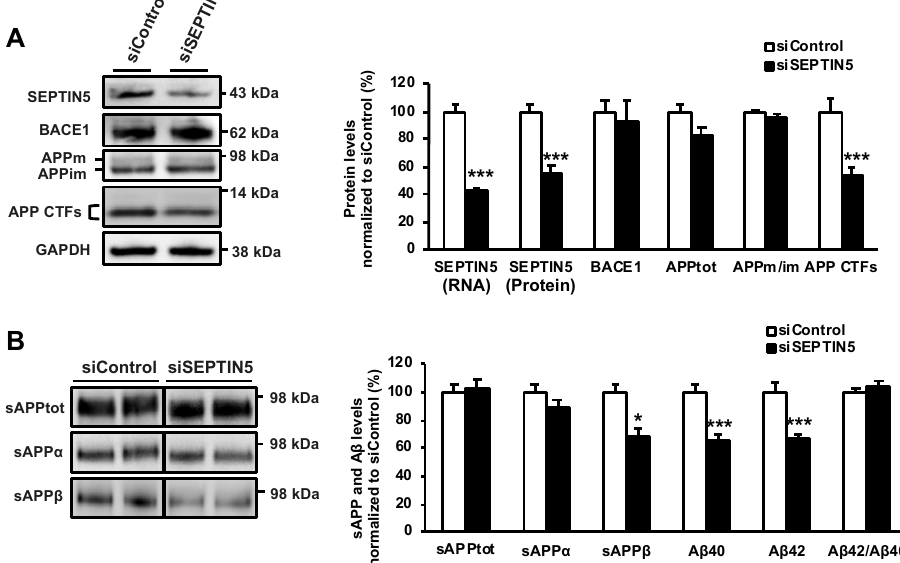
Figure 1. Downregulation of SEPTIN5 decreases the levels of amyloid precursor protein (APP) C-terminal fragments, sAPP β and A β in SH-SY5Y-APP751 cells. ( A ) Quantitative PCR and Western blot analysis to assess the effects of the downregulation of SEPTIN5 (siSEPTIN5) on APP processing in SH-SY5Y-APP751 cells. The levels of APP C-terminal fragments (CTFs) showed a significant decrease upon the downregulation of SEPTIN5 as compared with the control cells (siControl); ( B ) Levels of sAPP β (Western blot) and A β (ELISA) measured from cell culture medium indicated a decrease upon SEPTIN5 downregulation. The levels of sAPPtot and APP α remained unchanged. In (A), protein levels were normalized to GAPDH and are shown as a % of siControl. In (B), protein levels were normalized to total protein levels in the respective cell lysates and are shown as a % of siControl. n = 4–0, mean ± SEM, independent t-test, * p < 0.05, *** p < 0.001.